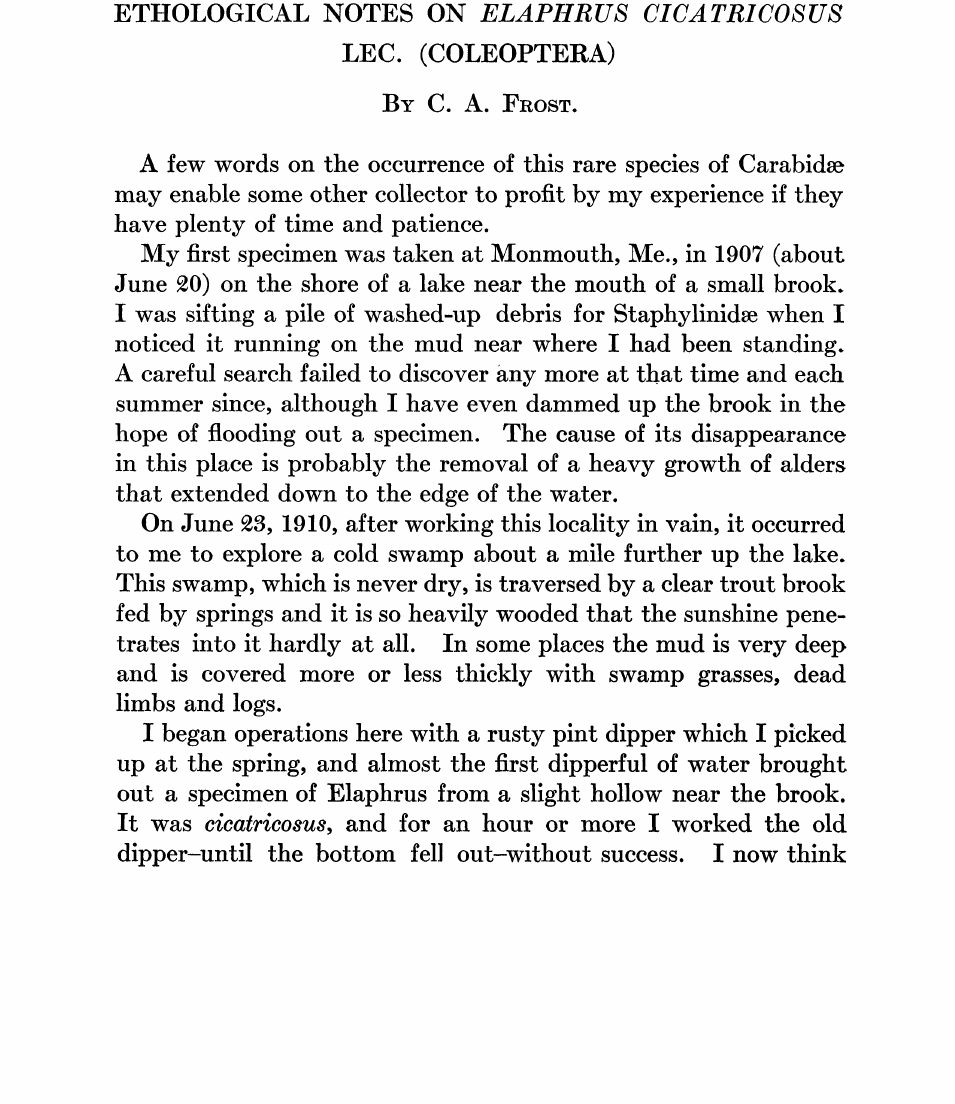
wings only there is a trace of two bands beyond discal spot. This variety can be told at a glance by the striking red-brown band across fore wings making it resemble slightly XanthorliSe